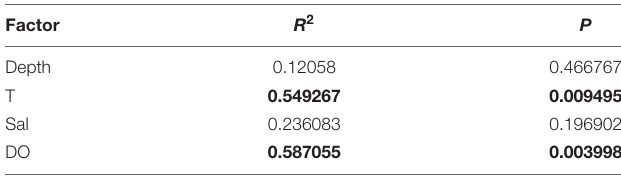
TABLE 4 | Spearman analysis of community variability in terms of Sal, DO, T, and depth among sampling